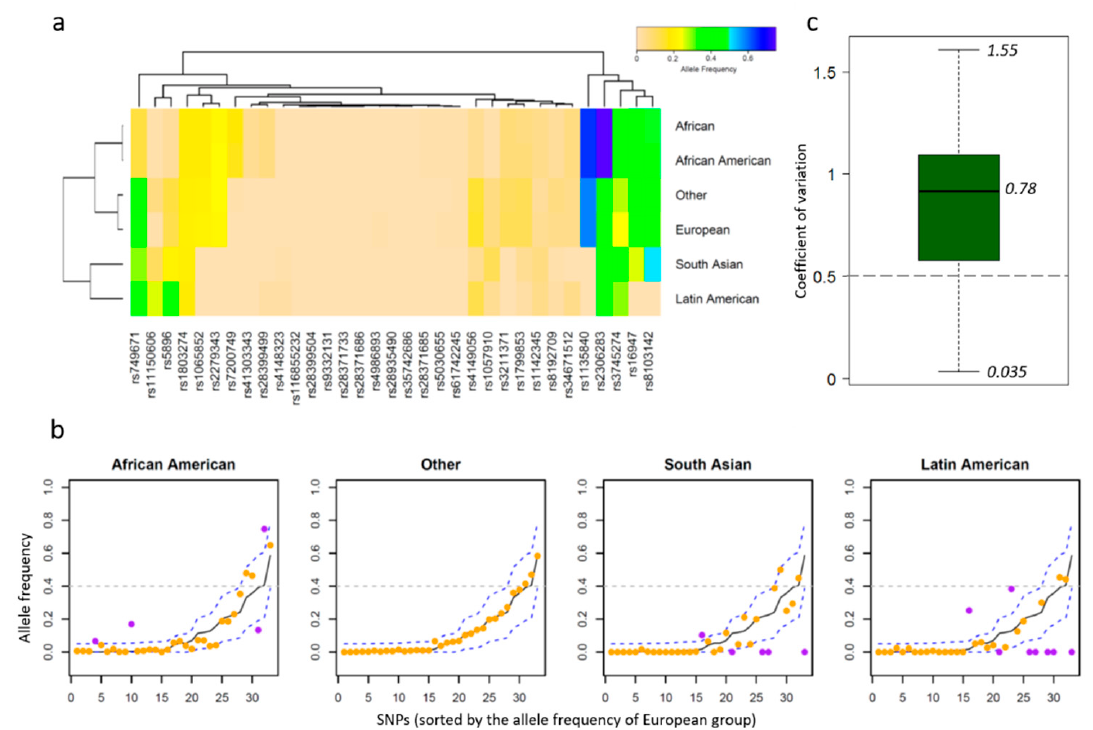
Figure 3. Analysis of the SNP allele frequency in diverse ethnic groups. ( a ) The heatmap of allele frequencies across ethnic groups (rows) and SNPs (columns). A two-way classification was performed on the allele frequency matrix. ( b ) The allele frequencies of the other four groups were plotted with those of the European population as baseline (middle black line). Any value beyond the thresholds (blue dash lines) is marked in purple, highlighting the substantial variability between ethnic groups. ( c ) The coefficient of variation distribution of SNP allele frequencies in six groups. The median coefficient of variation was 0.78, and 26 of 33 SNPs were with CVs over 0.5.